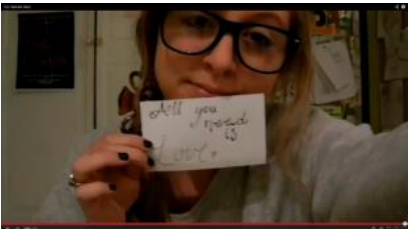
Figure 4. Final screenshot. Source: http://www.youtube.